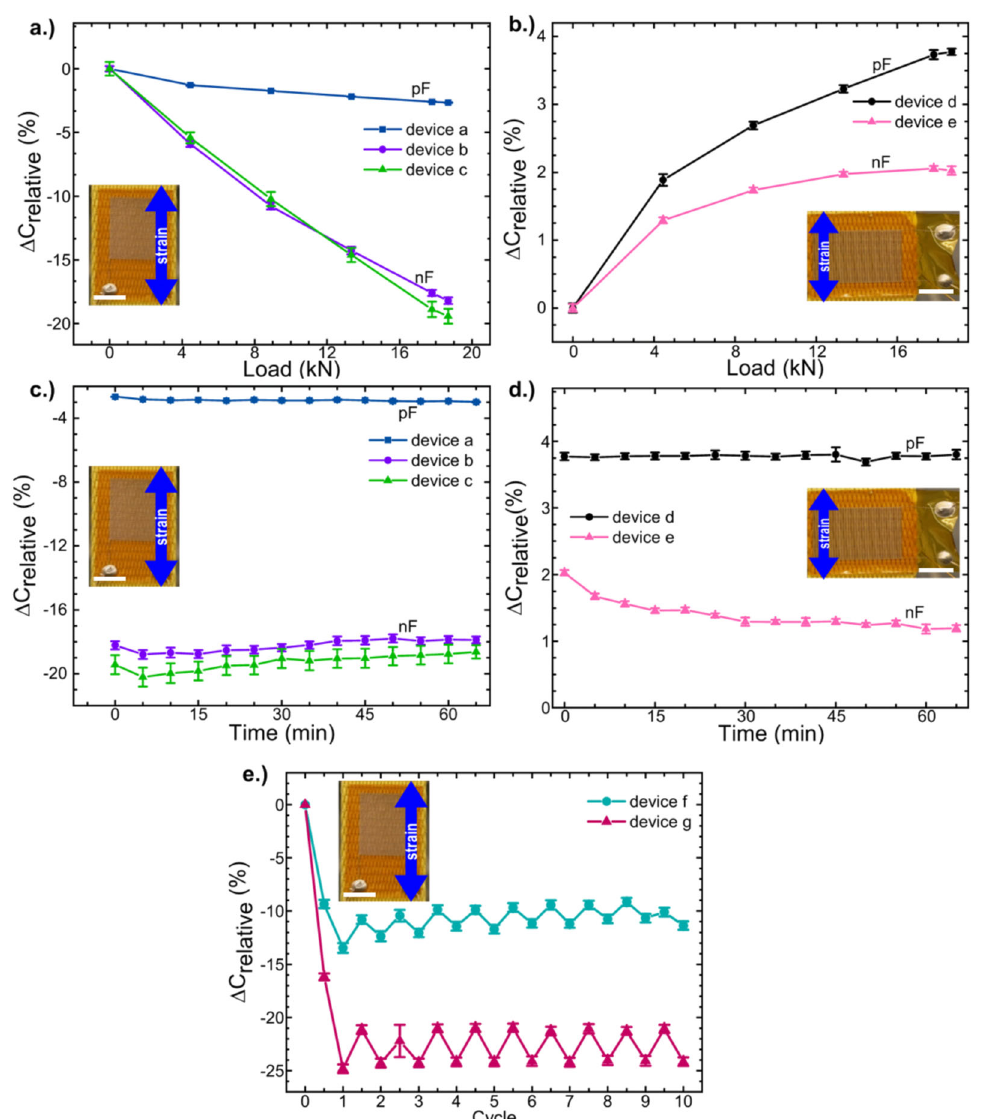
Fig. 4 Printed capacitance-based strain gauge dynamic, static and cyclic tensile testing results. Relative change in capacitance (%) for printed CSGs where a total of seven different devices (Table 1) were utilized for either dynamic (devices a – e ), static (devices a – e ), or cyclic (devices f , g ) testing. Results for dynamic testing with a target load of 18.7 kN for devices having electrodes a perpendicular (devices a – c ) and b parallel (devices d – e) to the direction of strain. Results for static testing performed at 18.7 kN for those same devices having electrodes c perpendicular (devices a – c ) and d parallel (devices d-e) to the direction of strain, and e cyclic testing of two different devices ( f , g ) having electrodes perpendicular to the direction of strain. Error bars are the estimated experimental uncertainty (Supplementary Discussion). In all images, scale bars represent 1.0